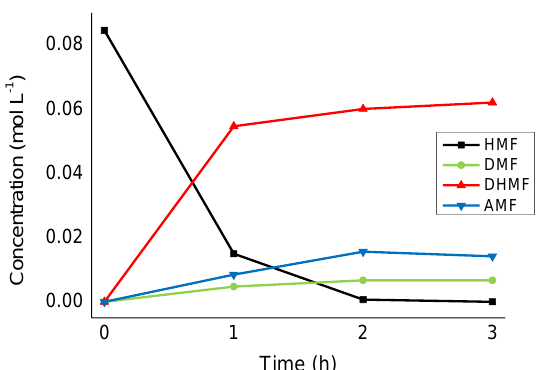
Figure 7. HMF hydrogenation reaction profile on Ru/CNFs-O. Reaction conditions: HMF, 0.08 M, substrate/metal = 100 mol/mol, solvent, 15 mL 2-butanol, 150 °C, 20 bar H 2 .